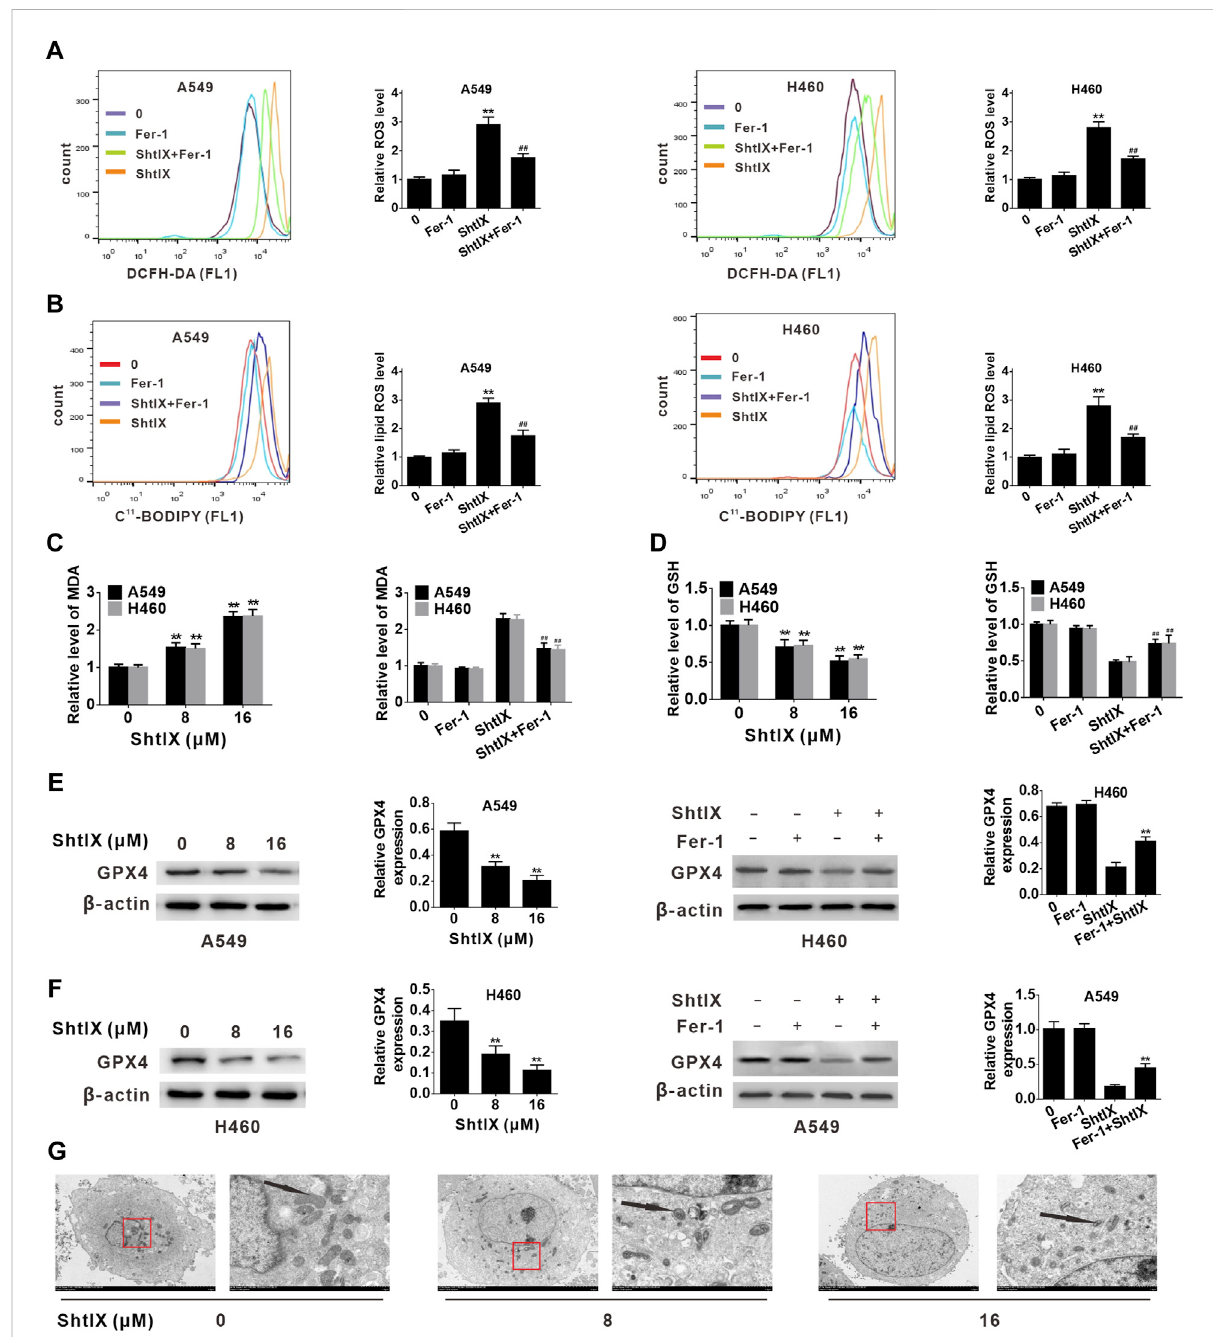
FIGURE 5 ShtIX inducesferroptosis inNSCLC cells. (A) A549 and H460 cells were treated with 16 μ MShtIX orShtIX combined with Fer-1 for 24 h, and the level of ROS was detected by fl ow cytometry. (B) Cells were treated as (A) , then stained with BODIPY ™ 581/591 C11 dye and lipid peroxidation was observed by fl ow cytometry. (C) Cells were treated with 8 and 16 μ M ShtIX or 16 μ M ShtIX combined with Fer-1 for 24 h, the MDA level was measured. (D) Cells were treated as (C) , the GSG level was measured. (E,F) The expression of GPX4 was analyzed by western blot. (G) Transmission electron microscopy images of A549 and H460 cells were treated with indicated dose of ShtIX. Scale bars: 5.0 µm; 1.0 µm. Data are expressed as mean ± SD of triplicate experiment. * p < 0.05, ** p < 0.01, # p < 0.05, ## p <